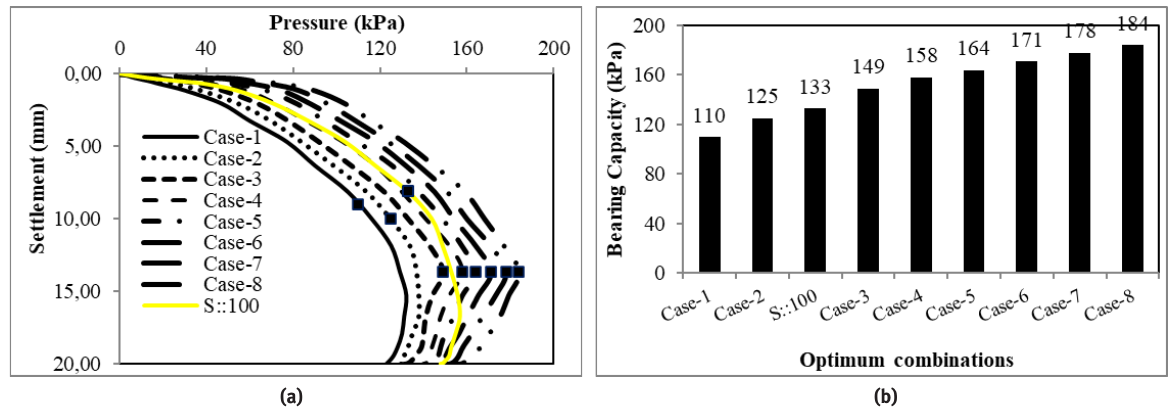
Figure 6: (a) Pressure–settlement curves and (b) bearing capacity values of two-layered soil for all cases at h/B=0.7 and single-layer sandy soil for